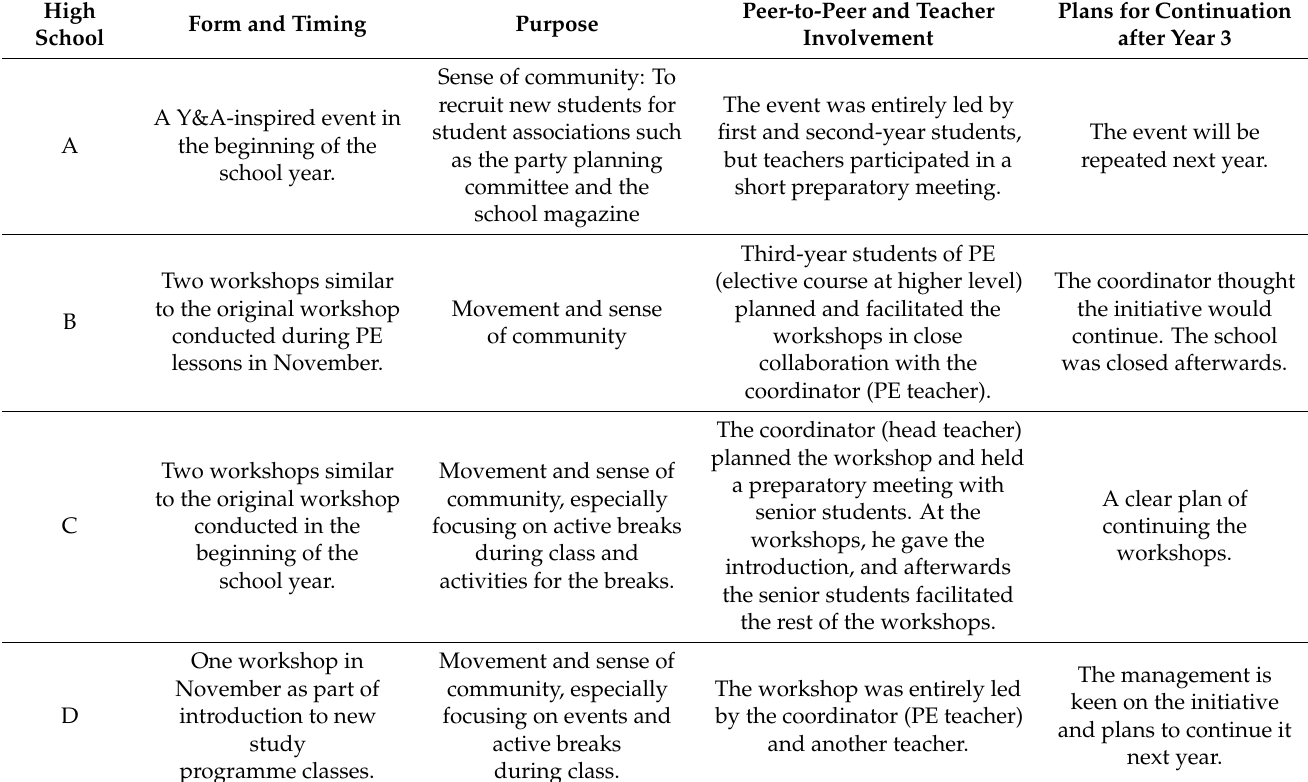
Table 3. Overview of the implementation of Young and Active (Y&A) in year 3 at intervention schools.